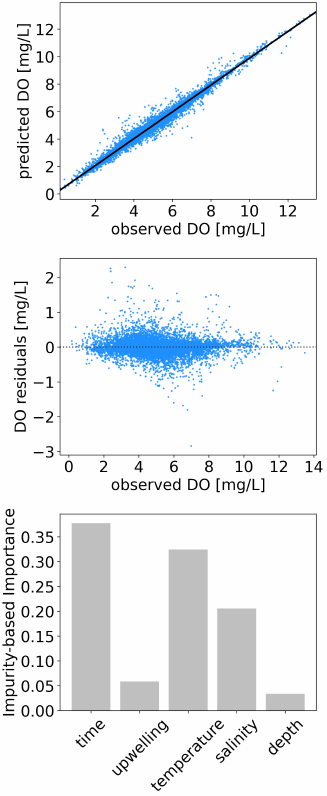
Figure 7. Nearshore model relational plot for Random Forest Regression ( top ) with R 2 = 0.987, along with the residuals plot ( center ) and relative impurity-based importance ( bottom ).